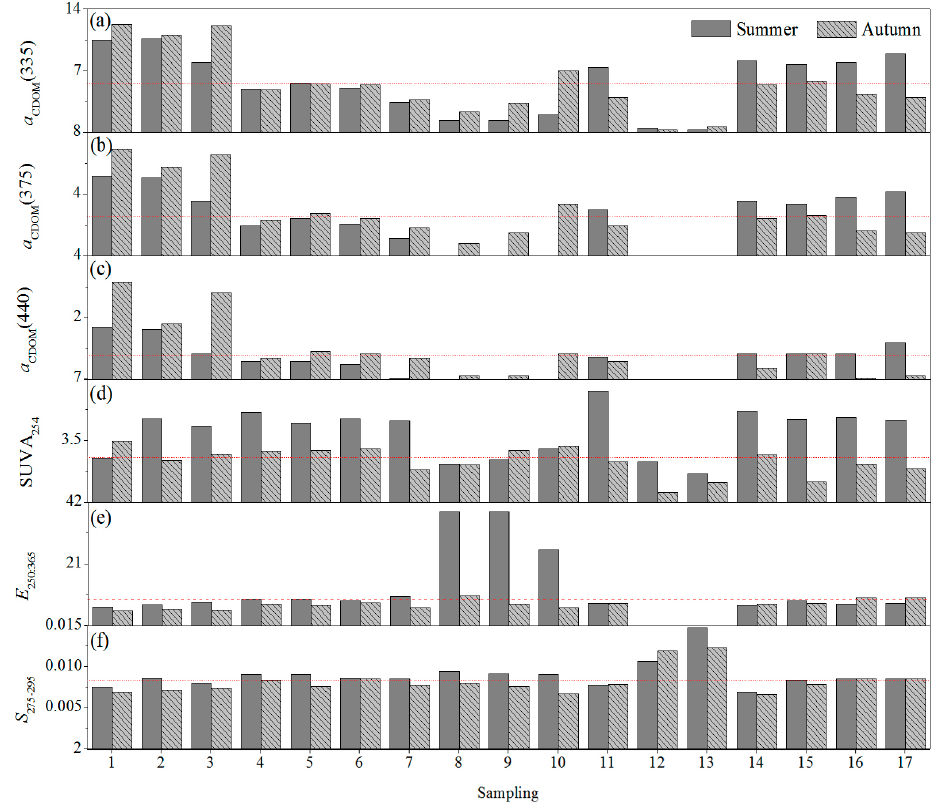
Figure 6. The histogram of a CDOM (335), a CDOM (375), a CDOM (440), SUV 254, E 250:365 and S 275–295 in different sampling locations: ( a ) a CDOM (335); ( b ) a CDOM (375); ( c ) a CDOM (440); ( d ) SUVA 254 ; ( e ) E 250:365 ; ( f ) S 275–295 . Units of the absorption coefficients of CDOM are m − 1 , and the unit of SUVA 254 is L ∙ mg ∙ C − 1 ∙ m − 1 .